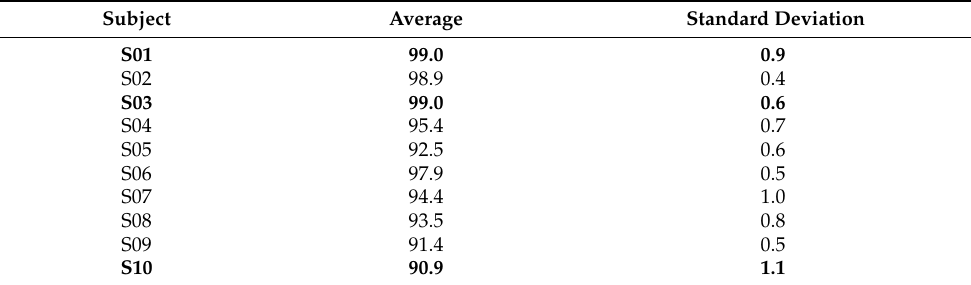
Table 6. Average classification accuracy (expressed in percentage) for the image model trained to classify the performance of the AR models of the ten subjects that participated within the data collections of the InSync